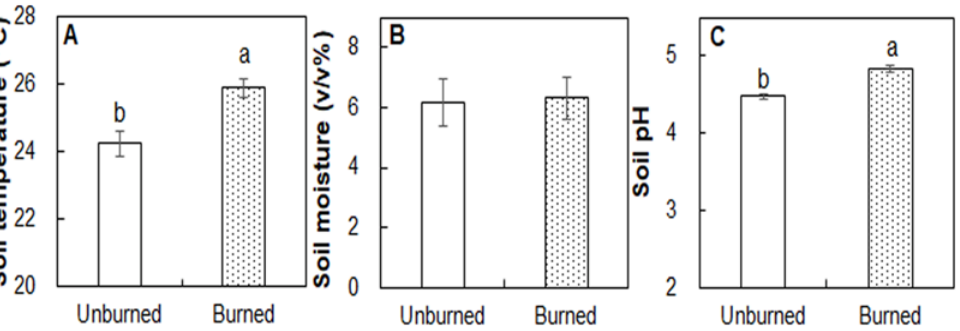
Figure 1. Differences in soil temperature ( A ), moisture ( B ), and pH ( C ) between the unburned and burned plots. Different letters indicate significant differences between treatments at p < 0.05. Values are presented as the means ± standard error.